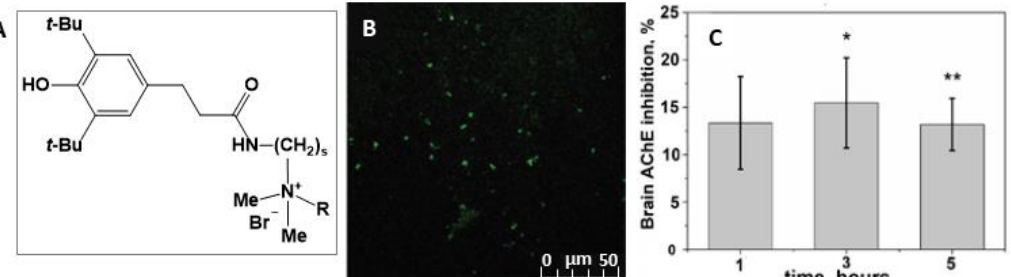
Figure 2. Structures of sterically hindered phenol containing quaternary ammonium moiety (SHP-s-R), where s = 2, 3; R=CH 2 Ph (SHP-2-Bn); R=C n H 2n+1 , n = 8, 10, 12, 16 (SHP-2-R) ( A ); Section of rat cerebral cortex ( B ); Determination of brain AChE inhibition level in vivo ( C ) after intranasal administration of PC/SHP-2-Bn/SHP-2-16 nanoparticles. * p = 0.028 and ** p = 0.004 indicate differences by Mann–Whitney test. Reprinted with permission from [40]. Copyright 2020 Royal Society of